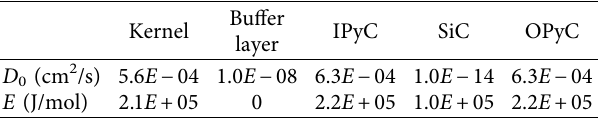
Table 2: Diffusion